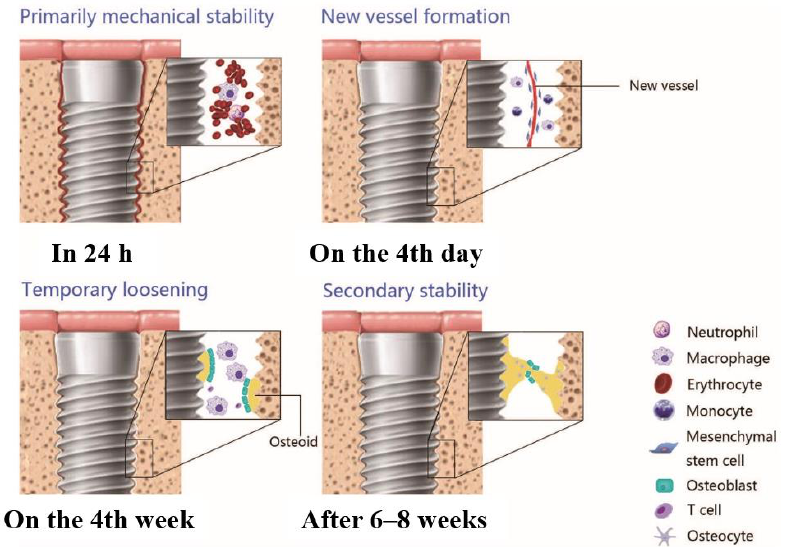
Figure 1. The process of osseointegration over time [18]. Reprinted with permission from Ref. [18]. 2015, John Wiley and Sons.